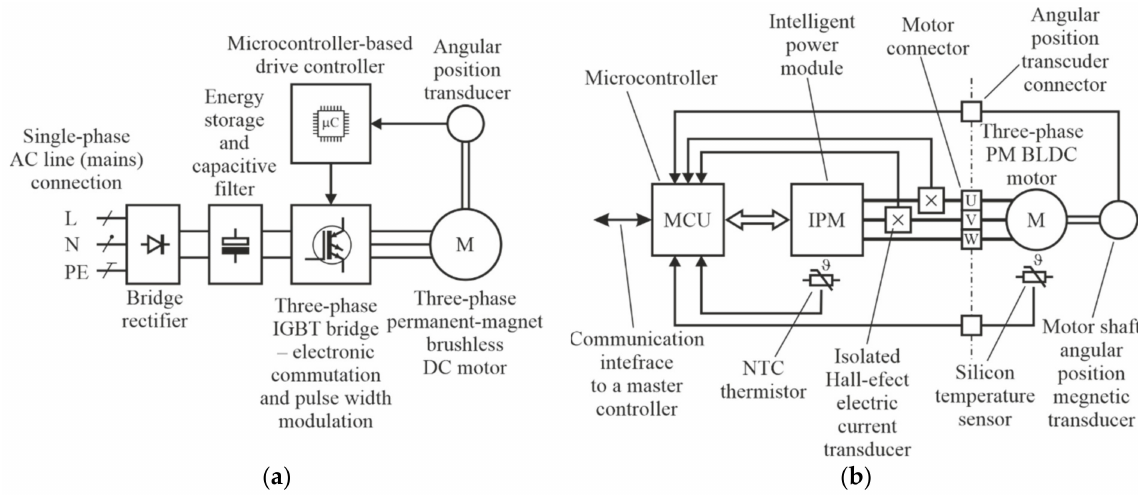
Figure 1. Key components of the permanent magnet brushless DC motor drive system. ( a ) High-current circuit structure. Power stage acts as a commutator and a pulse width modulation (PWM). The PWM can be a source of high-frequency disturbances. This structure lacks a power factor corrector (PFC) filter that would mitigate higher harmonics. ( b ) Control system structure. It contains monitoring sensors for overheating and overcurrent detection. Each of the transistors in the intelligent power module (IPM) is independently controlled by the microcontroller unit (MCU). The IPM takes care of some safety constraints.